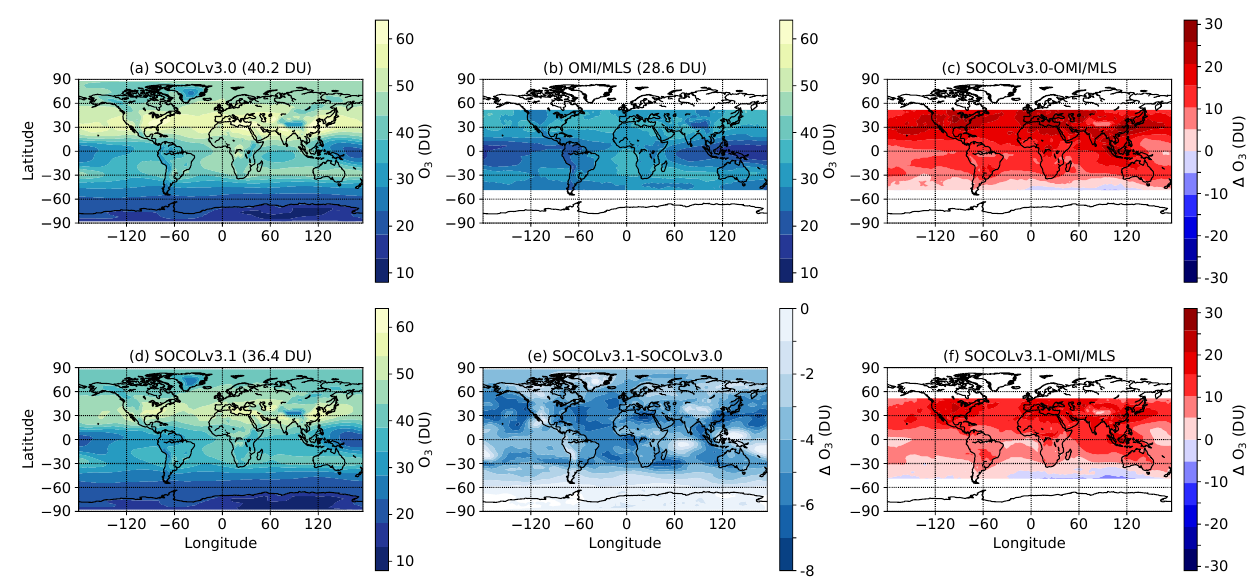
Figure 2. Annual-mean year 2005 tropospheric column for (a) SOCOLv3.0; (b) OMI/MLS observations; (c) the difference between SO- COLv3.0 and OMI/MLS; (d) SOCOLv3.1; (e) The difference between SOCOLv3.1 and SOCOLv3.0; (f) the difference between SOCOLv3.1 and OMI/MLS. The global-mean tropospheric column ozone amount is indicated in the title for (a) , (b) and (d) .